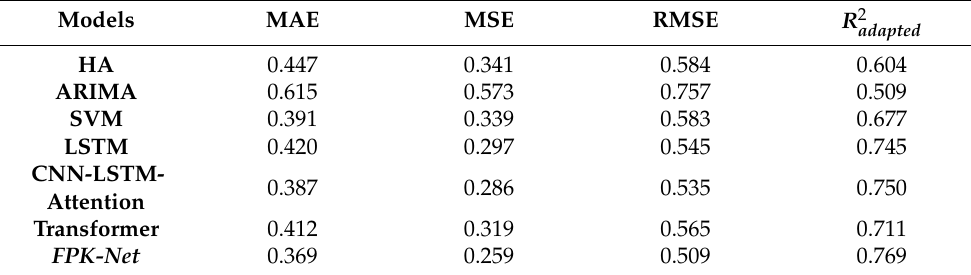
Table 1. Performance comparison of different methods on the